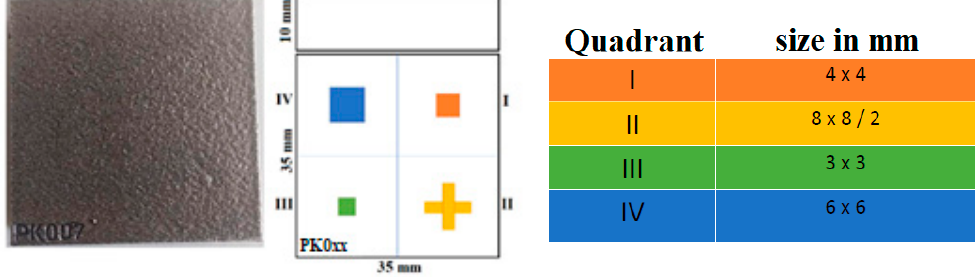
Figure 1 . An example of analyzed samples: defect depth 0.4 mm, height 1 mm, defects build in keyhole